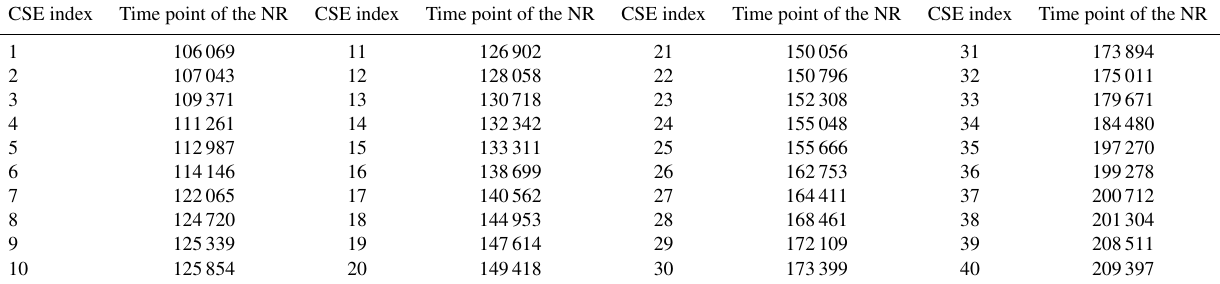
Table A1. Time points of the NR providing the initial conditions of the 40 independent CSEs. The initial time point coincides with the time when observations are available, i.e., only every T a = 8 steps, and the formula underneath the table provides the exact initial time point from the value in the table for a given parameter of T .